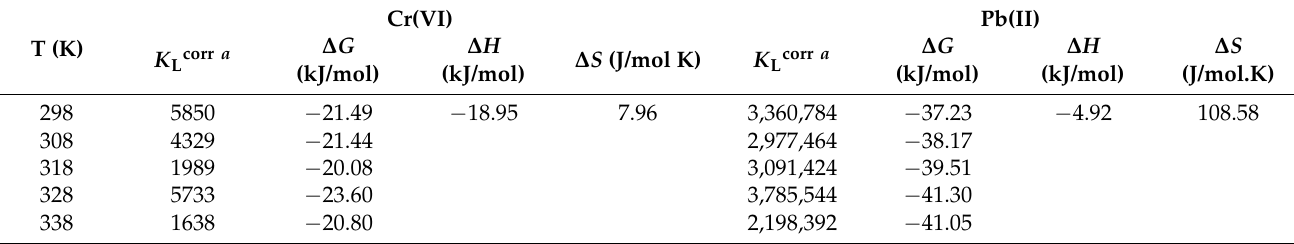
Table 4. Thermodynamic parameters for the adsorption of Cr(VI) and Pb(II) on the AC. Conditions: Cr(VI) and Pb(II) C i: 10–70 mg/L; AC dose: 10 g/L; Cr(VI) pH: 2, Pb(II) pH: 6; and the contact time: 1 h.